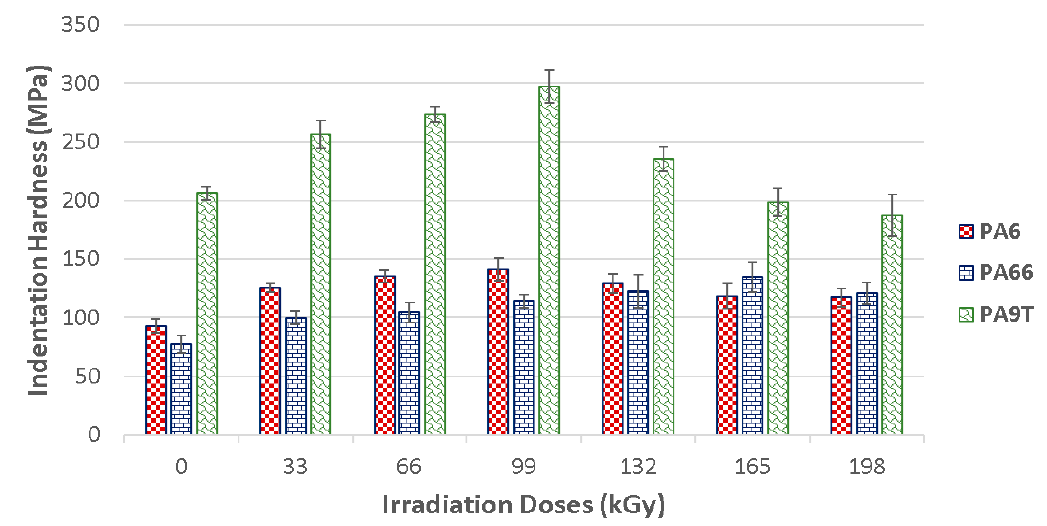
Figure 7. Indentation hardness (H IT ) of irradiated PA 6, PA 66 and PA 9T.